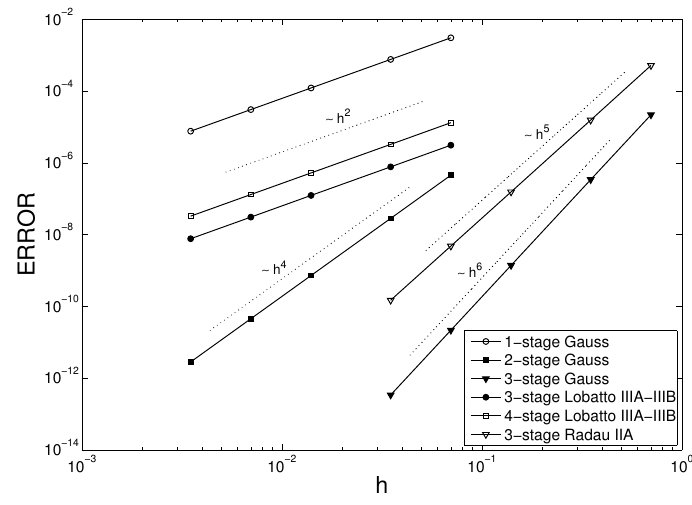
Figure 6. Convergence of several Runge–Kutta methods for the system of two point vortices.